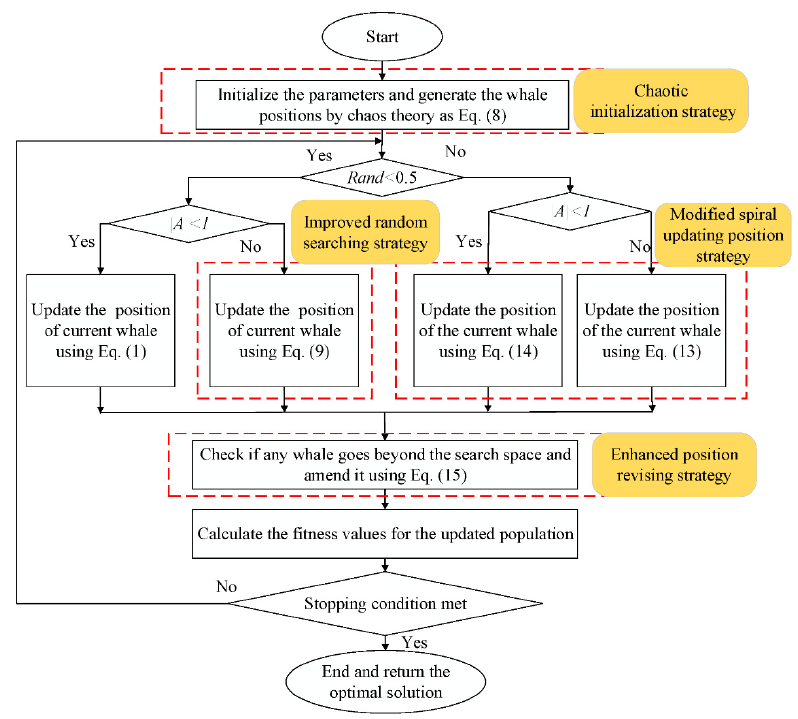
Figure 3. Framework of the multi-strategy ensemble whale optimization algorithm (MSWOA).